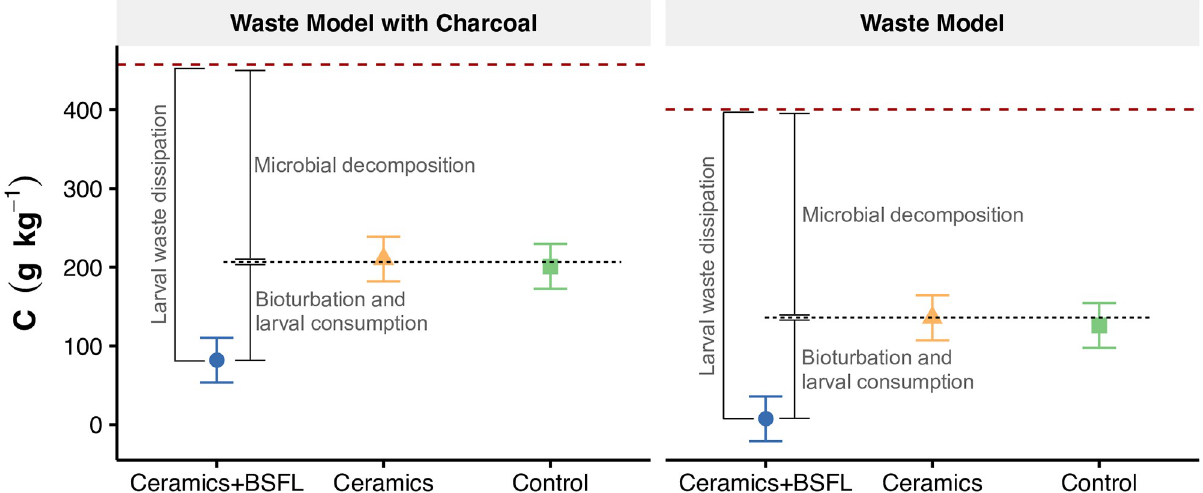
Fig 3. Final total carbon concentrations as influenced by the waste model and treatments. The presence of larvae significantly decreased soil C content relative to the other treatments. Herein, the waste model with charcoal (WMC; 5% charcoal w/w) exhibited higher C concentration than the waste model without charcoal (WM). The error bars represent the 95% confidence intervals (CI) and the red-dashed lines represent the total organic C concentration in the initial waste material.